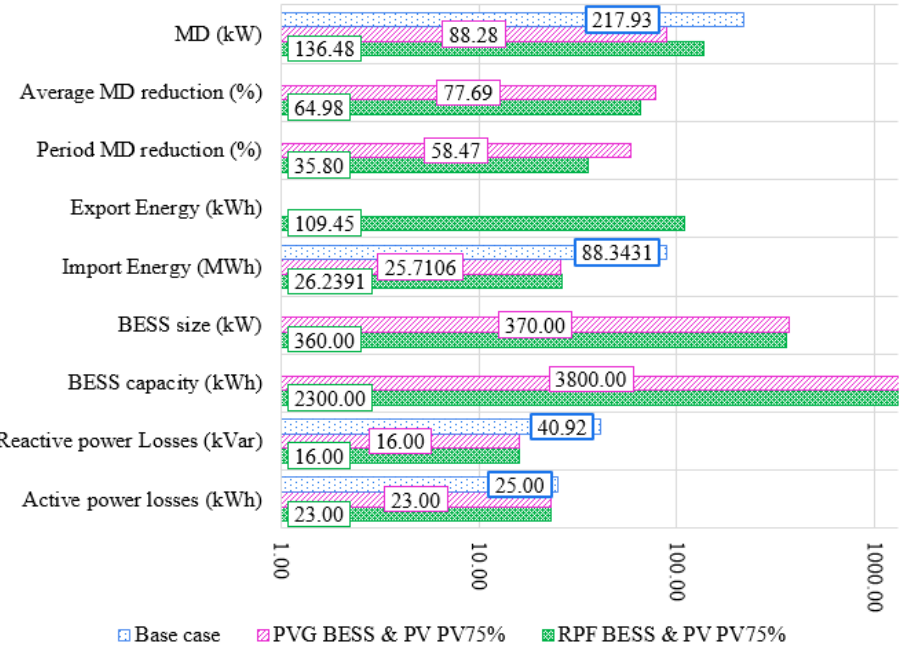
Figure A3. Comparison of PVGS and RPFS with 75% PV penetration level (January 2016).